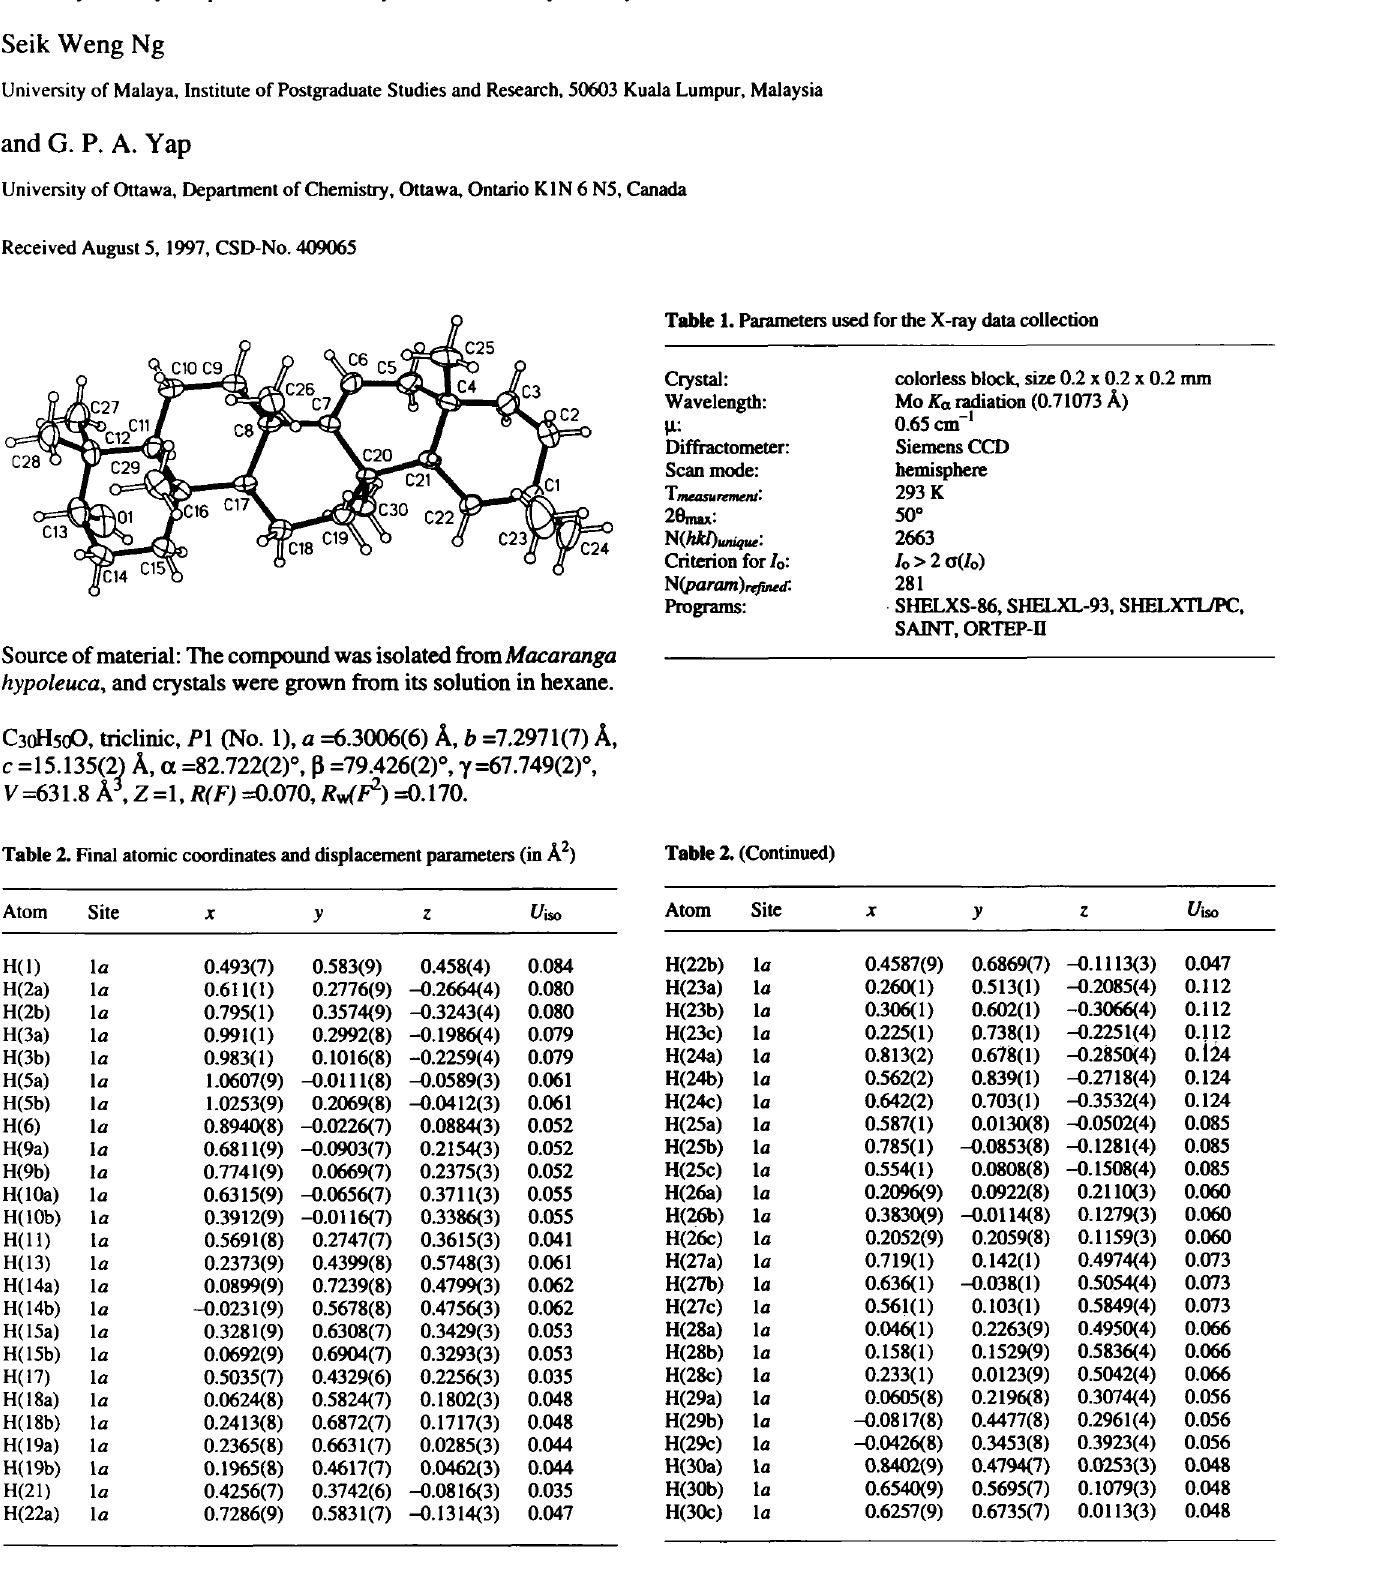
Table 1. Parameters used for the X-ray data collection